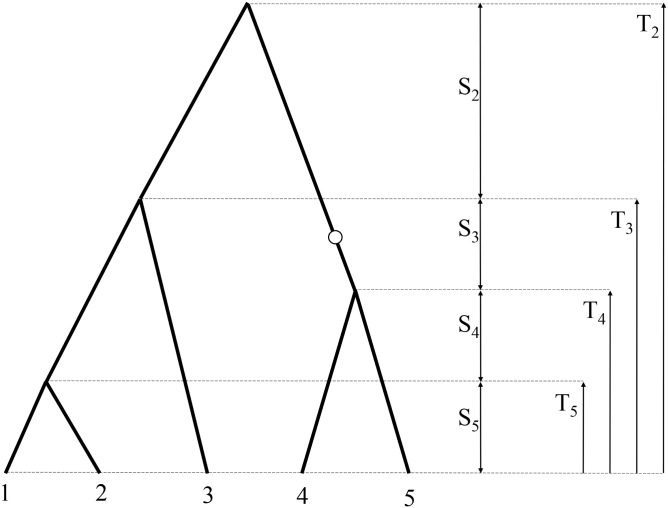
Coalescence tree and notation for ancestral history of a sample of n = 5 DNA sequences.Times to coalescence events are denoted by capital letters T, times between coalescences are denoted by capital letters S. A mutation event is marked by an open circle.